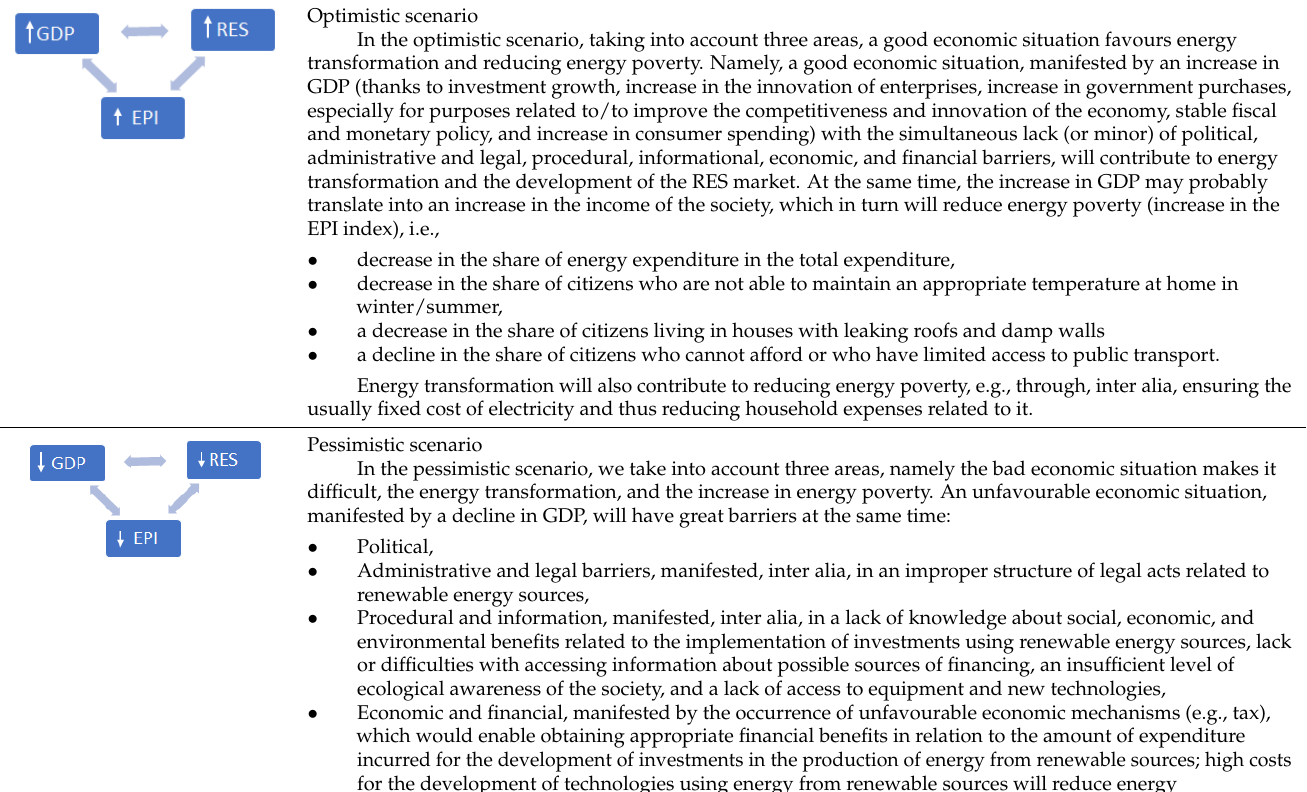
Table 2. Renewable energy development scenarios.